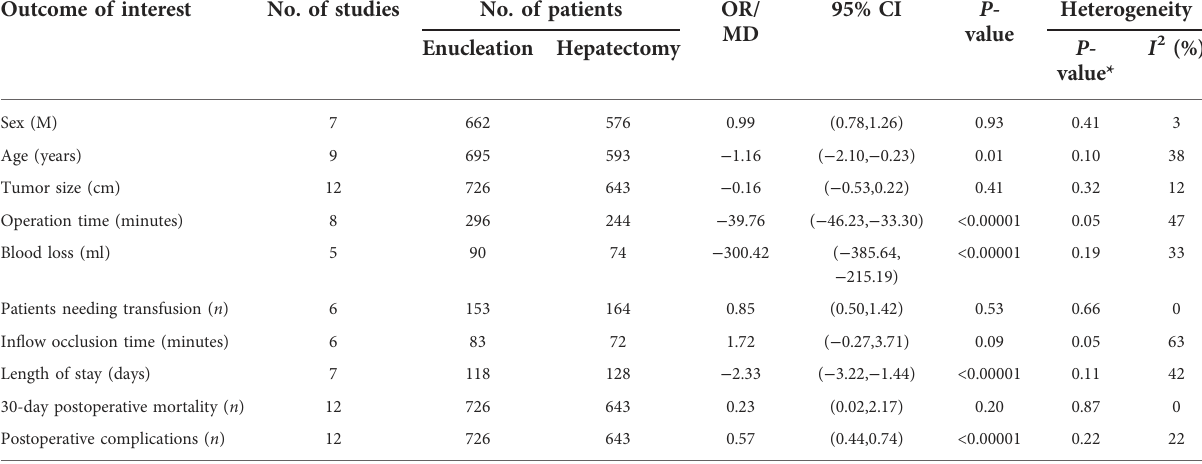
TABLE 4 Results of a meta-analysis comparing enucleation and hepatectomy for hepatic hemangioma.